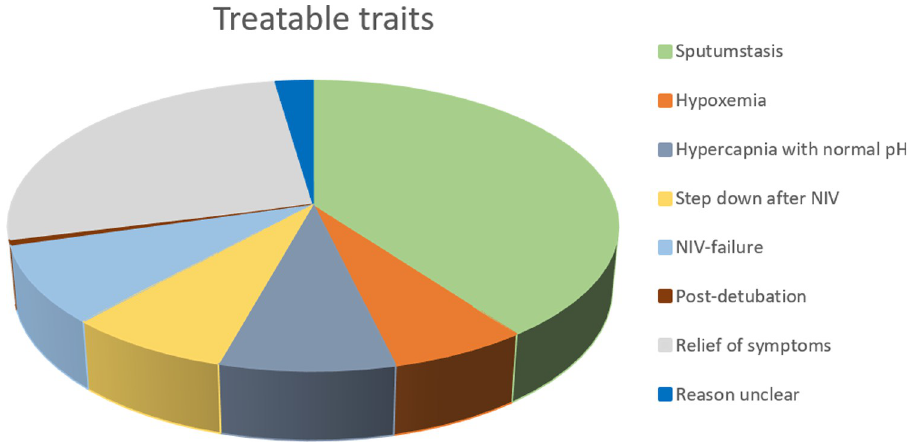
Fig 2. Treatable traits for HFNC in included